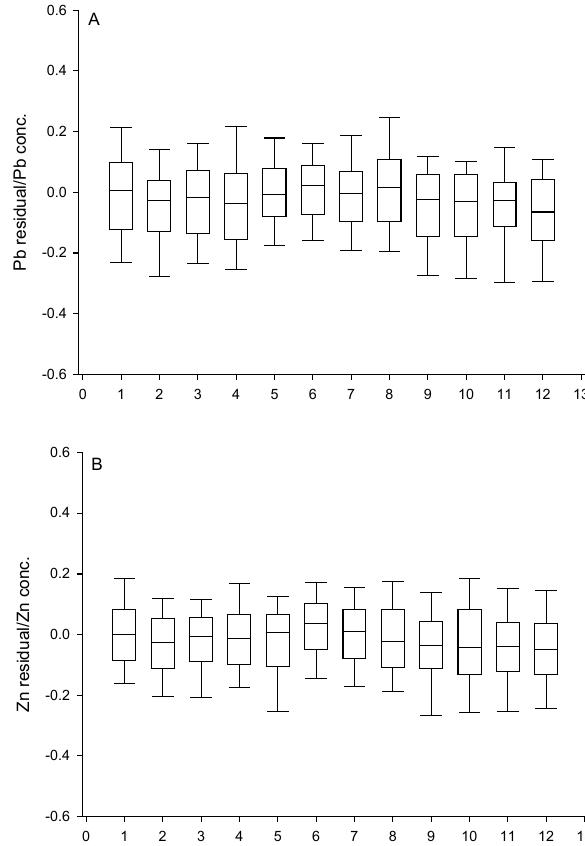
Fig. 5. Model residuals (untransformed, excluding Aneboda IM for Figure 5. Model residuals (untransformed, excluding Aneboda for Zn) by month for Pb (A) Zn) by month for Pb (A) and Zn (B) and Zn (B).